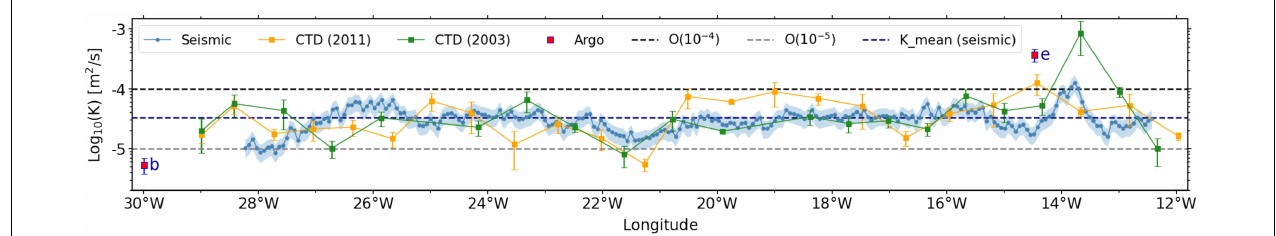
FIGURE 6 | Depth-averaged diffusivities derived from seismic and CTDs in the zonal direction, plotted with depth-averaged diffusivities calculated from two Argo profiles (green and cyan dots in Figure 1 ). Blue shade represents uncertainties of seismic estimates discussed in section “Depth- and Zonally-Averaged Diffusivity.” Error bars show the standard error of depth-averaged diffusivity of CTD/Argo profiles.